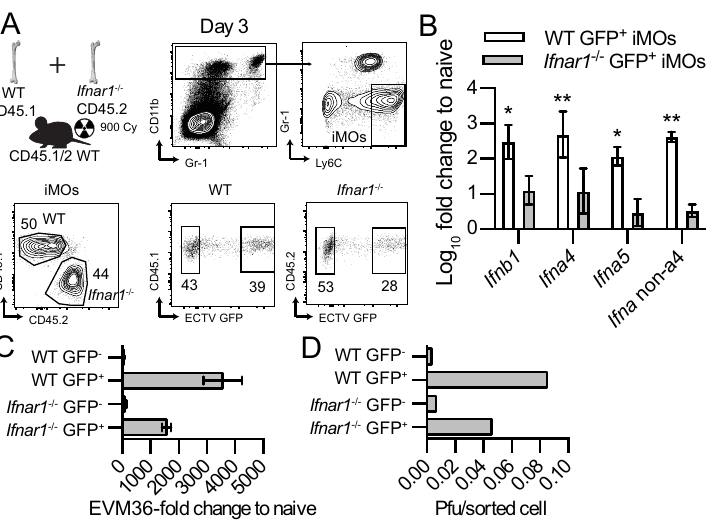
Fig 7. iMOs require intrinsic IFNAR for optimal transcription of IFN-I genes. (A) Mixed BMC B6.CD45.1 + Ifnar1 -/- ! F1 [B6.CD45.1 x B6.CD45.2] were infected with 3000 pfu of ECTV-GFP in the footpad and at 3 dpi, uninfected (GFP - ) and infected (GFP + ) WT and Ifnar1 -/- iMOs were sorted from the popliteal dLNs as shown in the representative flow cytometry plots. Created with BioRender.com. (B) IFN-I transcription quantification was performed by RT-qPCR using RNA extracted from each sorted population as a template. Transcript levels of Ifnb1 , Ifna4 , Ifna5 , and all Ifna except Ifna4 ( Ifna non-a4) were normalized to Gapdh . (C) Transcript levels of the ECTV EVM36 gene were quantified as in (B) . (D) Indicated sorted populations were lysed, and ECTV loads in the indicated iMOs populations were quantified by plaque assay. Data are represented as mean ± SEM from two pooled independent experiments for (B) and (C) and from one independent experiment for (D) (ratio paired Student t-test).